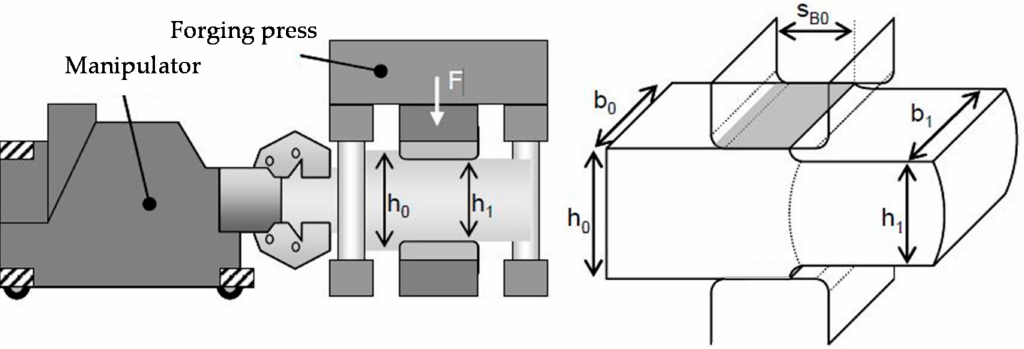
Figure 1. Outline sketch of an open-die forging process ( left ) including the most important geometric parameters ( right )